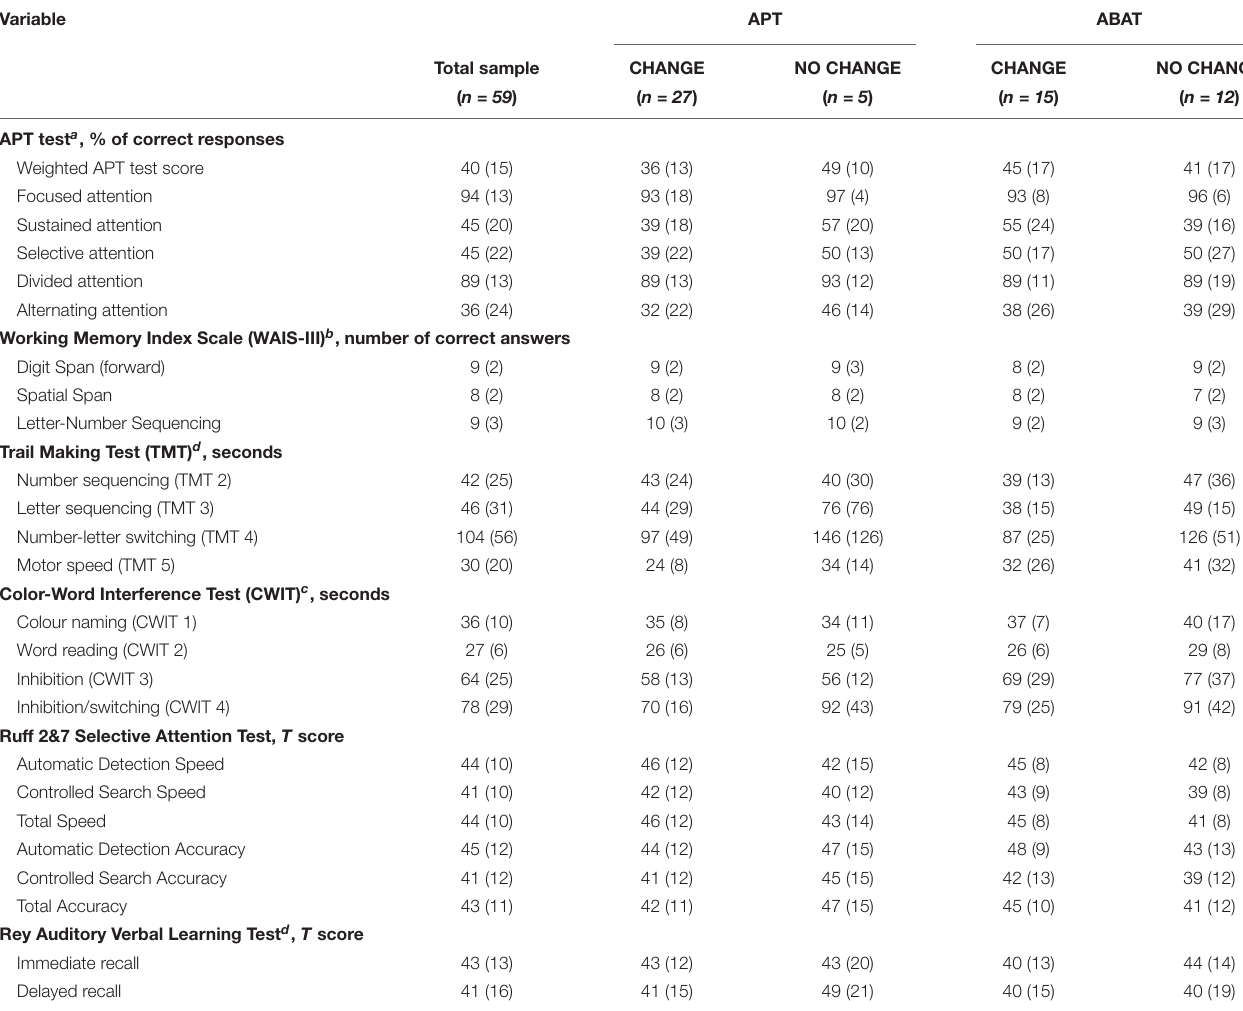
TABLE 3 | Neuropsychological characteristics of participants at baseline assessment according to the type of treatment and treatment outcome (CHANGE/NO CHANGE).